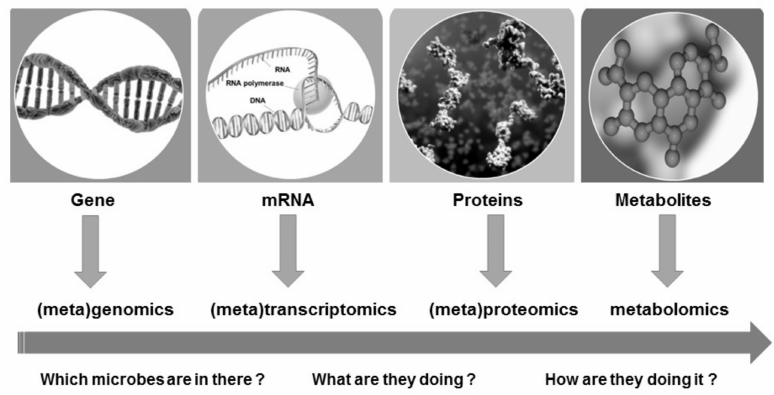
Figure 2. Meta-approaches for investigations of biocorrosion